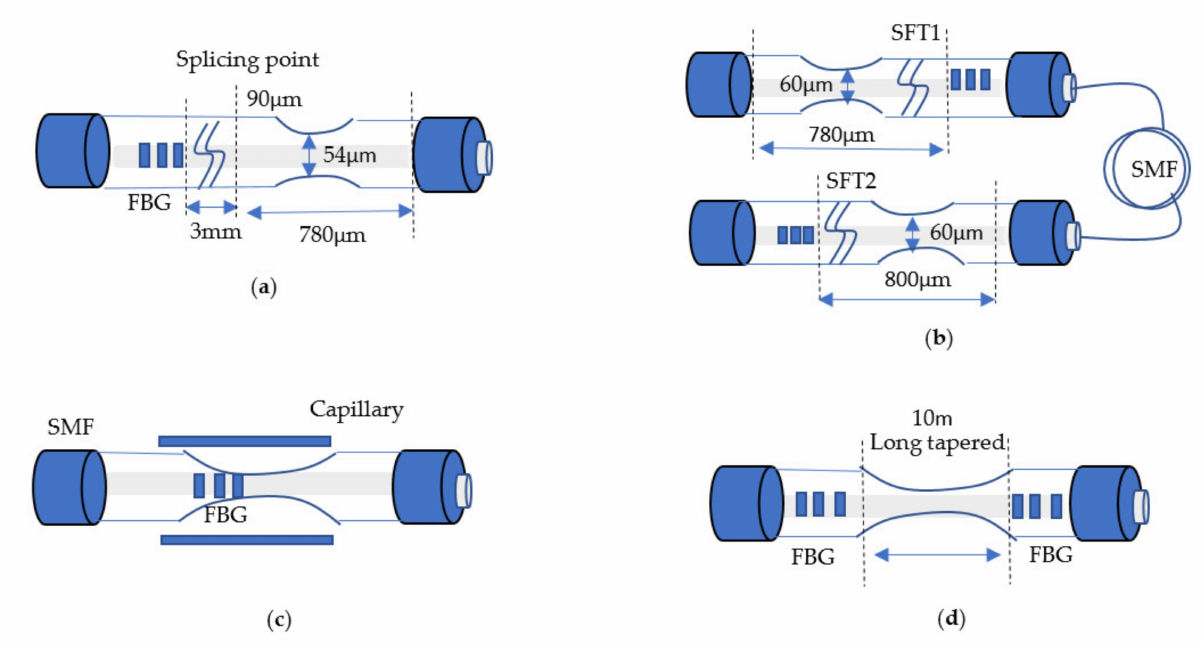
Figure 3. Tapered fiber optic based on FBG structures. ( a ) Illustration of hybrid S-taper/FBG structure [62]. ( b ) Illustration of cascaded S-taper/FBG structure [63]. ( c ) Illustration of Fabry–Perot/tapered FBG structure [70]. ( d ) Illustration of long tapered fiber/array of FBG structure